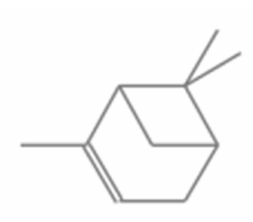
Figure 2. Chemical structure of α -pinene.